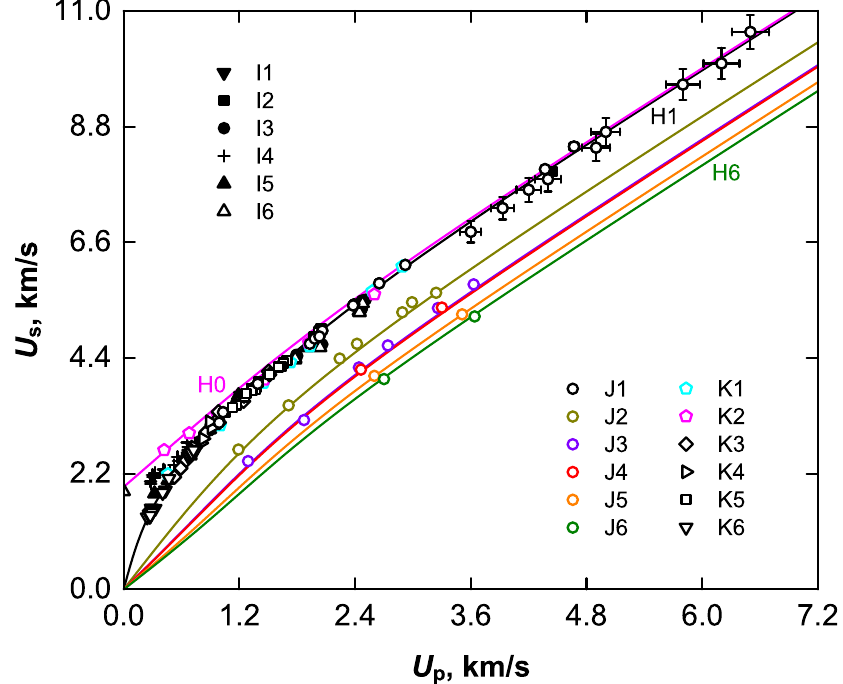
Figure 2. Shock adiabats of bismuth samples with different initial densities ( ρ 00 ) and initial tem- peratures ( T 0 ) at an initial normal pressure ( P 0 = 0.1 MPa): solid lines—results of calculations using the present model (curve H0 corresponds to the initial state of the liquid phase at T 0 = 673 K and ρ 00 = 9.89 g/cm 3 ; curves H1 to H6 correspond to the initial state of the solid phase at room temperature and ρ 00 = 9.8, 6.62, 5.1, 5, 4 and 3.44 g/cm 3 ); markers—experimental data